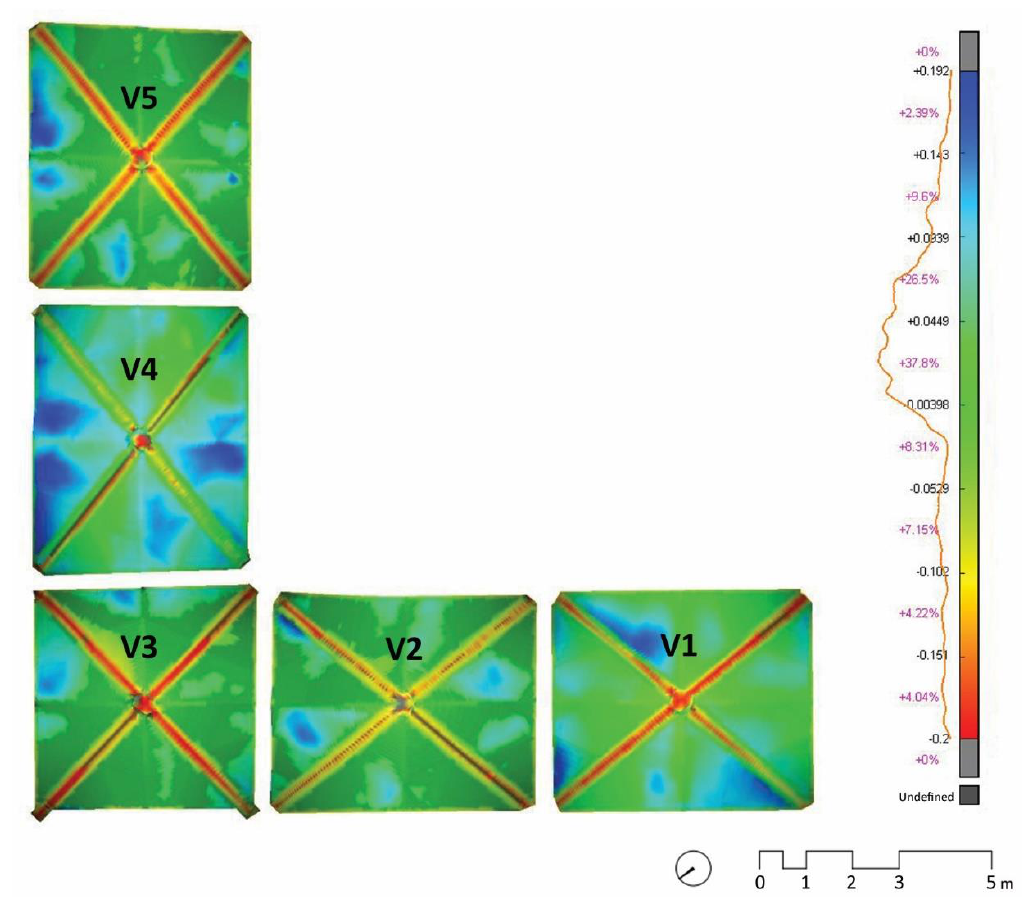
Figure 10. Distance maps of external walls (units in meters).